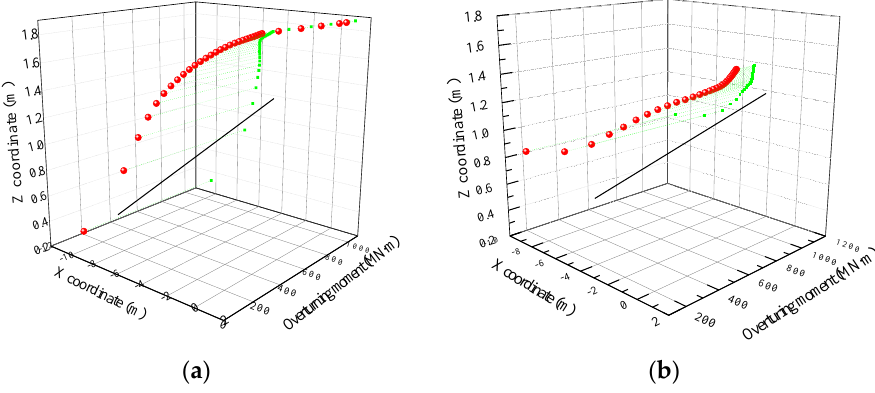
Figure 21. Rotation center under different overturning moments. ( a ) TSPJF, ( b ) TBJF.